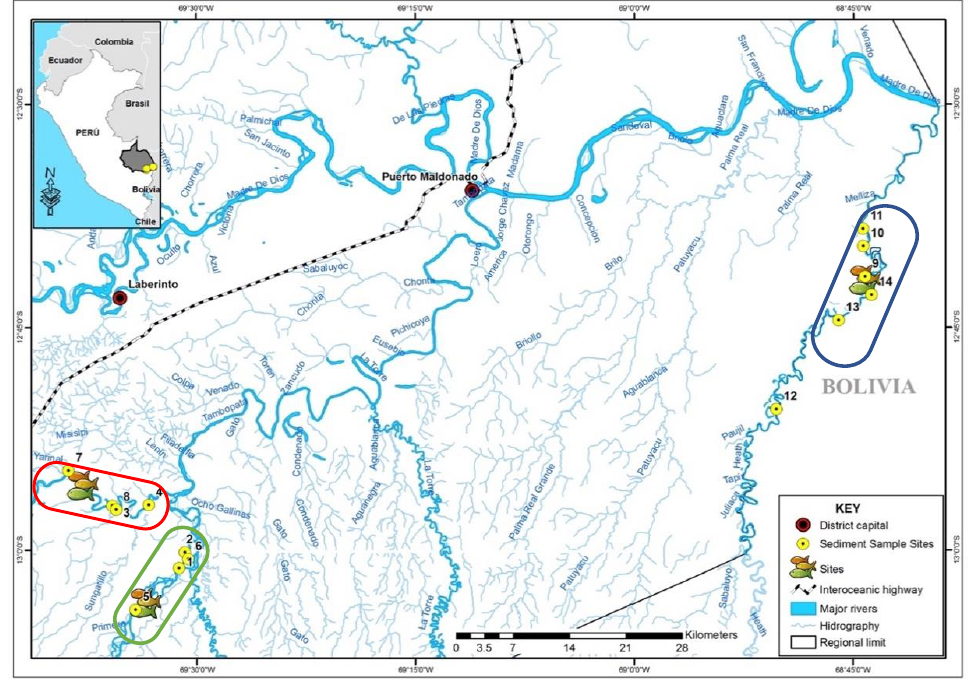
Figure 1. Map of the study region. Fish sampling for each season was conducted in the circled reaches for each river Tambopata River (green), Malinowski River (red), and Heath River (blue). Circles indicate sediment sample sites. The Interoceanic Highway is denoted with a dashed line.